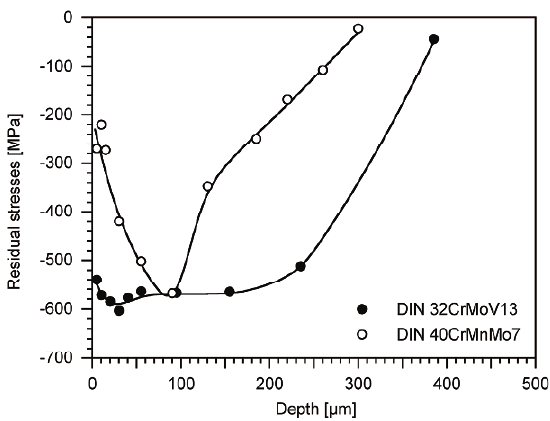
XRDABM methodology point out that the yield strength vs depth is different for both nitrided steels, showing clearly the differences between the two nitriding treatment conditions.